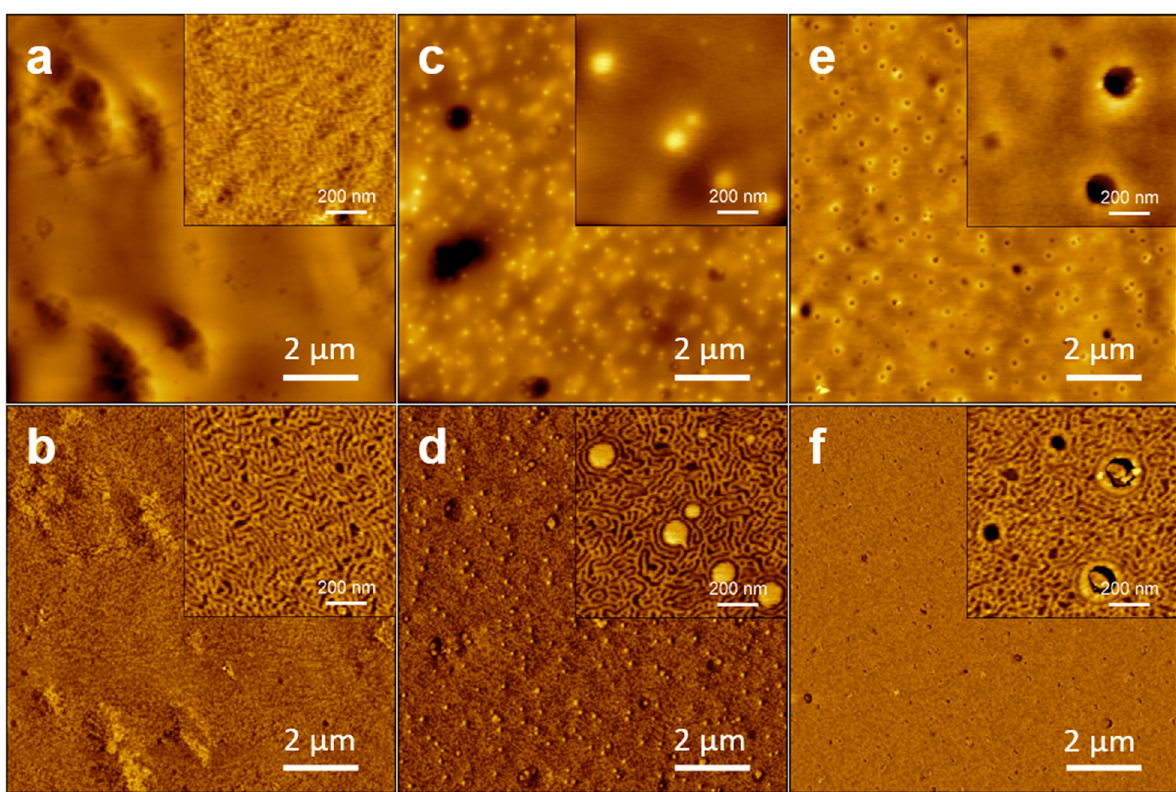
Figure 5. AFM images of SIBS and SIBS/TA formulations. ( a ) Height and ( b ) phase images of SIBS- B15; ( c ) height and ( d ) phase images of SIBS-B15 mixed with TA (5 wt %); ( e ) height and ( f ) phase images of SIBS-B15 mixed with TA (5 wt %) after storing in methanol for 1 h. Scale bars are 2 µm and 200 nm for the magnified insets.